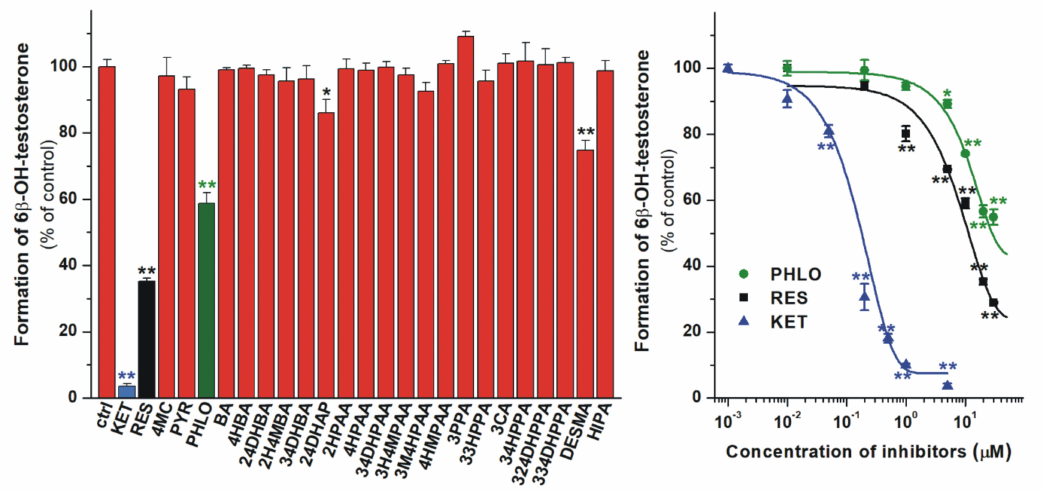
Figure8. Left: Inhibitorye ff ectsofcolonicflavonoidmetabolitesandketoconazole(KET,positivecontrol; each 20 µ M) on the CYP3A4-catalyzed testosterone (5 µ M) hydroxylation.